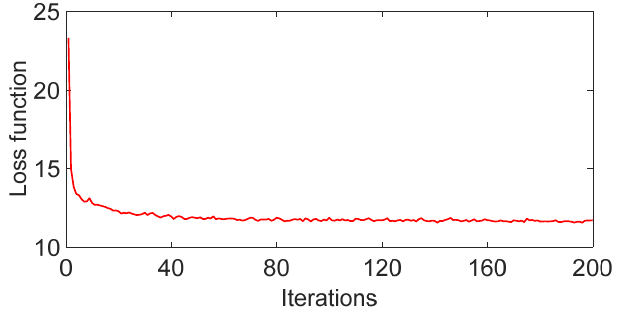
Figure 5. Evolution process of CVAE.